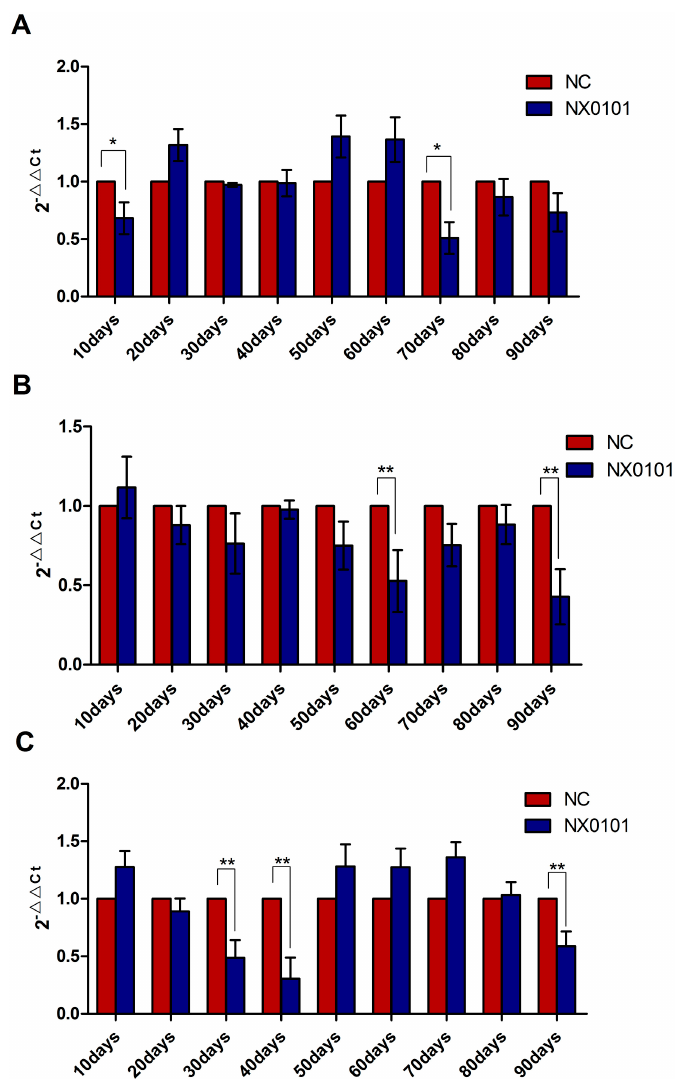
Figure 5. mRNA expression of BMF in the liver, spleen, and blood of chickens infected by ALV-J. ( A ) BMF mRNA expression levels in the liver of infected pullets from 10 to 90 days post infection. ( B ) BMF mRNA expression levels in the spleen of infected pullets from 10 to 90 days post infection. ( C ) BMF mRNA expression levels in the blood of infected pullets from 10 to 90 days post infection. ** p < 0.01, * p < 0.05.